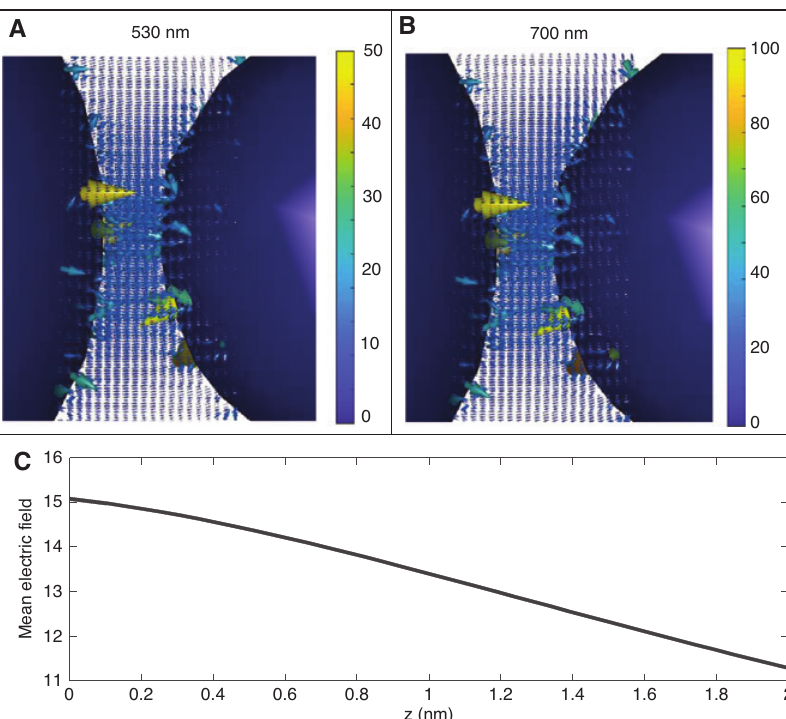
Figure 2: Hot spots where Raman conversion and its enhancement take place. (A, B) Electric field profiles of the two plasmon modes given in Figure 1B. Hot spots of the two modes overlap. (C) Mean electric field on the QE, which is proportional with the overlap integral [40] f , versus the position of the QE. (In units of incident electric